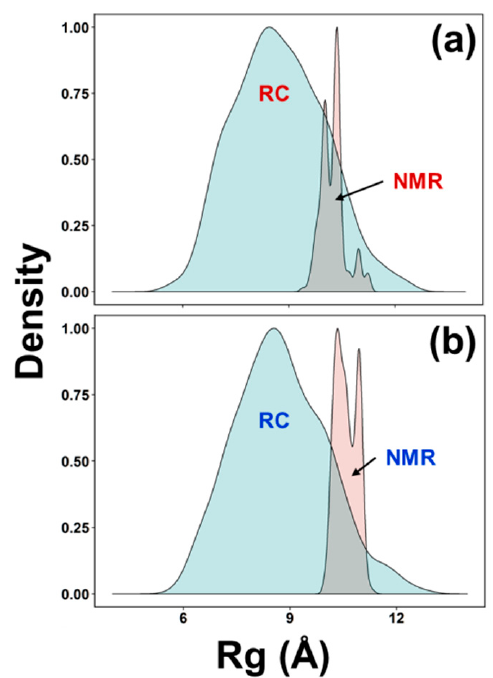
Figure 6. Comparison between the ensemble random coil and NMR-generated ensembles. ( a ) AFGP8-BS and ( b ) AFGP8-TB. The ensemble of the random coil (RC, light blue) and a large ensemble of NMR structures (NMR, light pink). The normalized density was calculated from an ensemble of 1000 structures each.